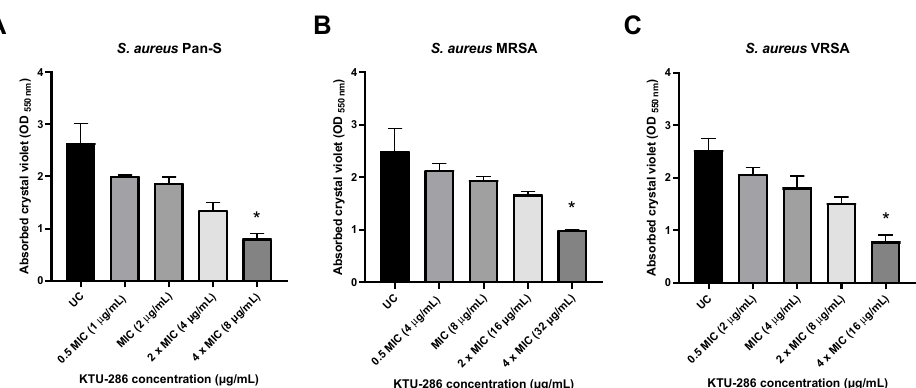
Figure 5. KTU-286 shows concentration-dependent S. aureus biofilm disrupting activity. Mature Pan-S ( A ), MRSA ( B ), and VRSA ( C ) biofilms were exposed to di ff erent concentrations of KTU-286 (0.5 MIC, MIC, 2 × MIC and 4 × MIC). Biofilm exposure to KTU-286 resulted in significant decrease of biofilm integrity ( p < 0.05) in comparison to that of untreated control. Biofilm exposure to KTU-286 for 24 h resulted in a significant ( p < 0.05) reduction in S. aureus biofilm integrity at the concentration four times higher than MIC. Data represent mean ± SD of triplicate experiments ( n = 3). Statistical di ff erences were determined using Kruskal–Wallis test. * p < 0.05.